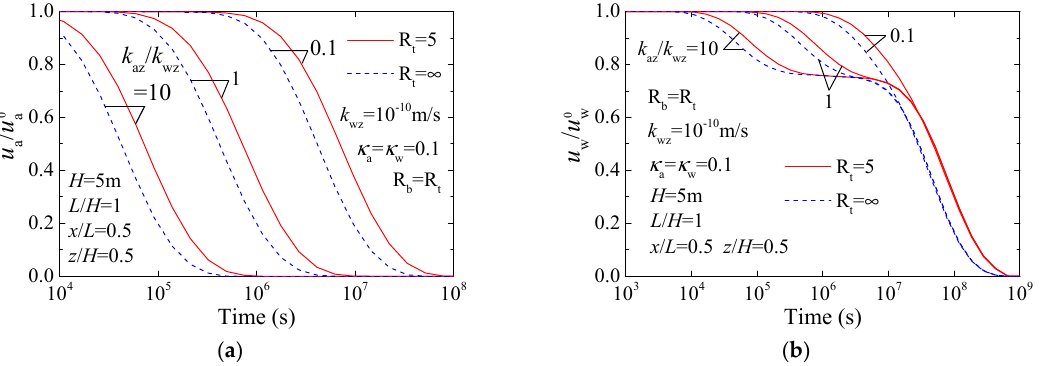
Figure 9. Variations of excess pore-pressures under vertical impeded drainage boundary with different air-water permeability ratios: ( a ) air phase and ( b ) water phase.